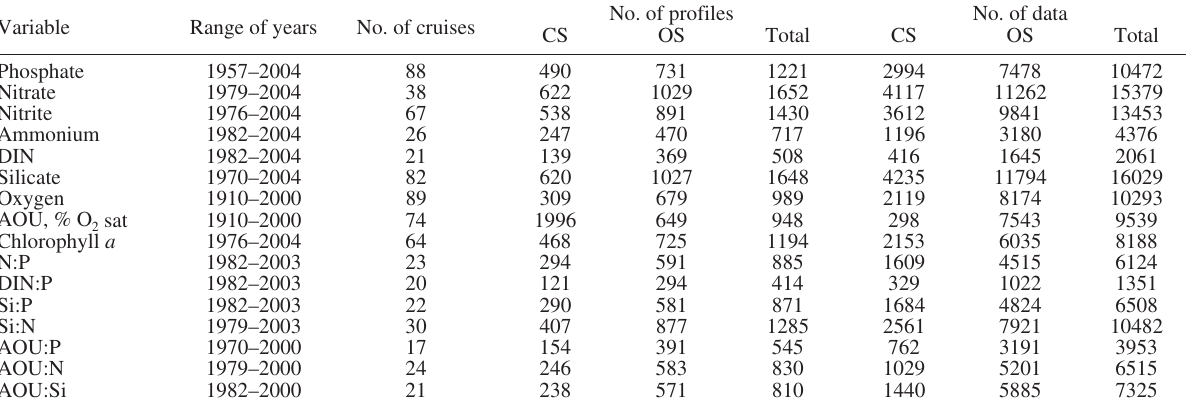
sat) and all the ratios. 2